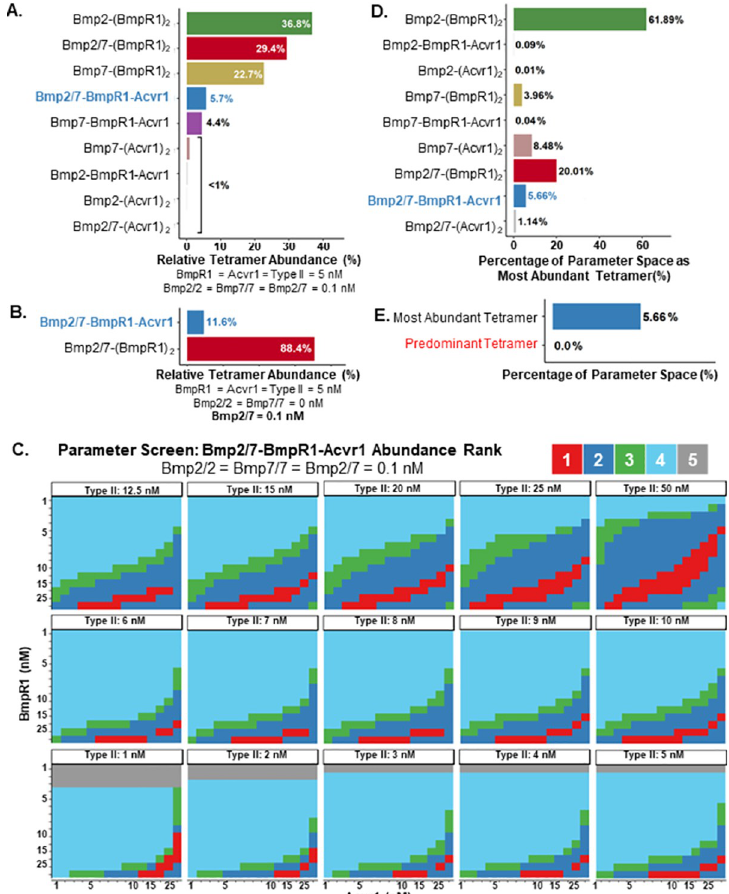
Fig 2. Oligomerization kinetics do not explain heterodimer-heterotetramer dominance. A. Proportion of ligand- receptor tetrameric complexes at equimolar receptor at physiological conditions. The heterodimer-heterotetramer is only the fourth most abundant tetrameric complex. B. Proportion of ligand-receptor tetrameric complexes in a simulation with no homodimer ligand. Heterodimer-heterotetramer production is still not kinetically favored. C. Visualization of the prevalence of heterodimer-heterotetramer compared to other ligand-receptor tetramers in 3,375 points of a 84,375 point screen. The red region represents parameter space in which the heterodimer-heterotetramer is the most prevalent species (3.84% of this sample. D. The portion of the parameter space in which each ligand-receptor tetrameric complex is the most abundant. E. The portion of the parameter space in which the heterodimer- heterotetramer is the most abundant ligand-receptor tetrameric complex (5.66%) and the predominant tetrameric complex (0.0%). homodimer ligands are removed from the model, leaving only the Bmp2/7 ligand, ligand and receptors favor formation of the Bmp2/7 complex with two BmpR1 and two type II receptors (Fig 2B). The heterodimer-heterotetramer signaling complex, Bmp2/7-Acvr1-BmpR1-(Type II) , was the most abundant tetrameric signaling complex in only 5.66% of the tested parame- 2 ters (Fig 2D and 2E). In contrast, Bmp2-(BmpR1) -(Type II) and Bmp2/7-(BmpR1) -(Type 2 2 2 II) were the most abundant tetramer complexes in 61.89% and 20.01% of parameter condi- 2 tions (Fig 2D). Surprisingly, we did not find a single solution in which the heterodimer-hetero- tetramer complex formation was predominant, as defined by a greater concentration than the total of the homodimer receptor complexes (Fig 2E). A visualization of a subset of the parame- ter space is shown in Fig 2C. The red region represents the 3.84% of physiologically relevant parameter space in which the heterodimer-heterotetramer is the most abundant tetramer.